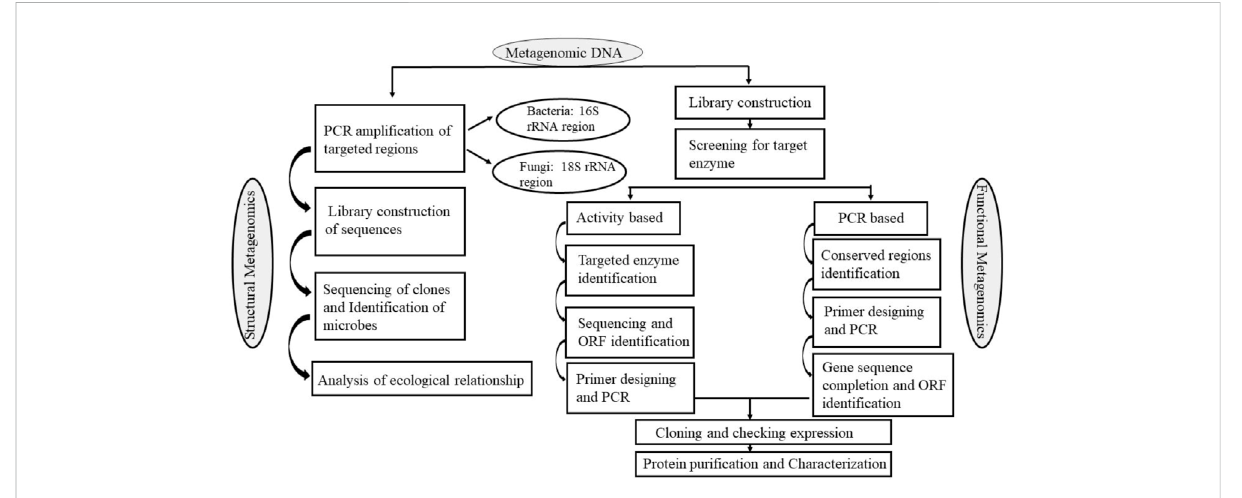
FIGURE 2 General strategies for enzyme mining using metagenomic